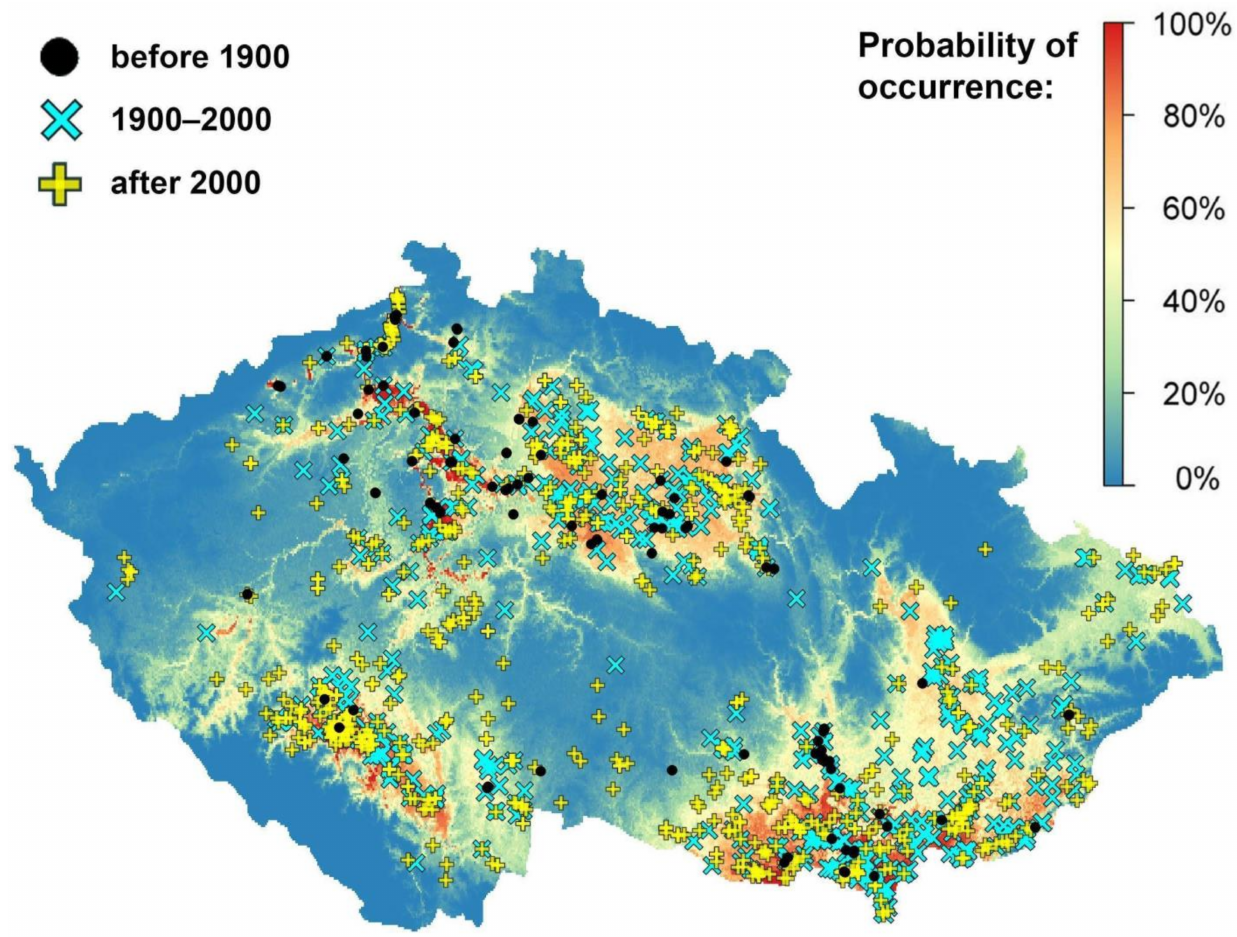
Figure 10. Predicted climatic suitability of habitats for Cyperus fuscus . The actual species’ occurrences are plotted with black circles, turquoise x-marks, and yellow